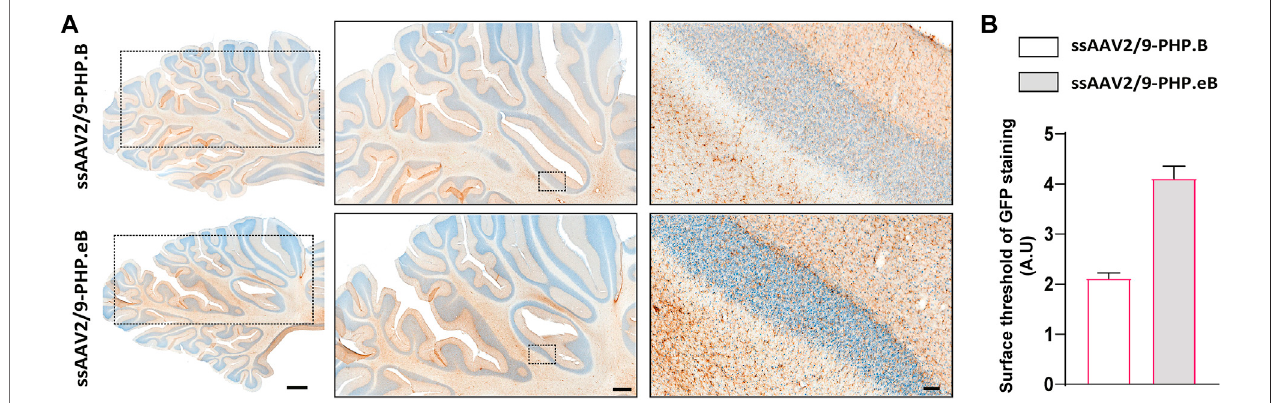
FIGURE 2 | Stronger widespread brain EGFP distribution after intrathecal injection of AAV-PHP. eB compared to variants AAV-PHP. B in the cerebellum of non- human primates. (A) Representative coronal brain sections at the cerebellum level (AC-17 mm) of EGFP immunostaining (left) and illustrative photomicrographs (middle and right)ofEGFP immunostainingin thecerebellum in monkeys injected witheitherAAV-PHP. B (up) or AAV-PHP. eB(down). Scale bars (cid:2) 2 mm (left, sections), 1 mm (middle, sections) and 100 µm (right, insets). (B) Quantitative analysis of EGFP immunostaining measured by surface threshold analyzed on four sections of the cerebellum in AAV-injected monkeys. Data represent mean ± SEM.